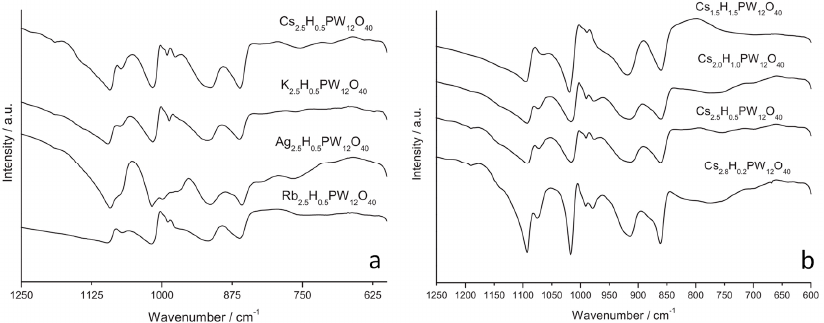
Figure 24. ( a ) FT-IR spectra of heteropolyacid support materials made by incorporating various metal ions. ( b ) FT-IR spectra of heteropolyacid support materials made by incorporating various about of Cs ions. Reprinted from Catal. Today, 248, S. J. Freakley, R. J. Lewis, D. J. Morgan, J. K.